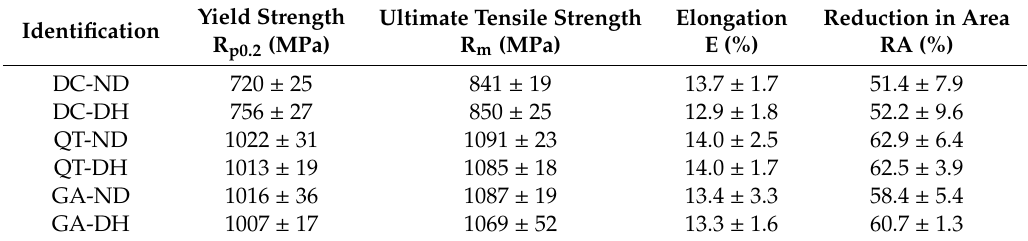
Table 6. Average values of mechanical properties obtained in SSRT at different stages of the production process of class 10.9 bolts with 30MnB5 steel.